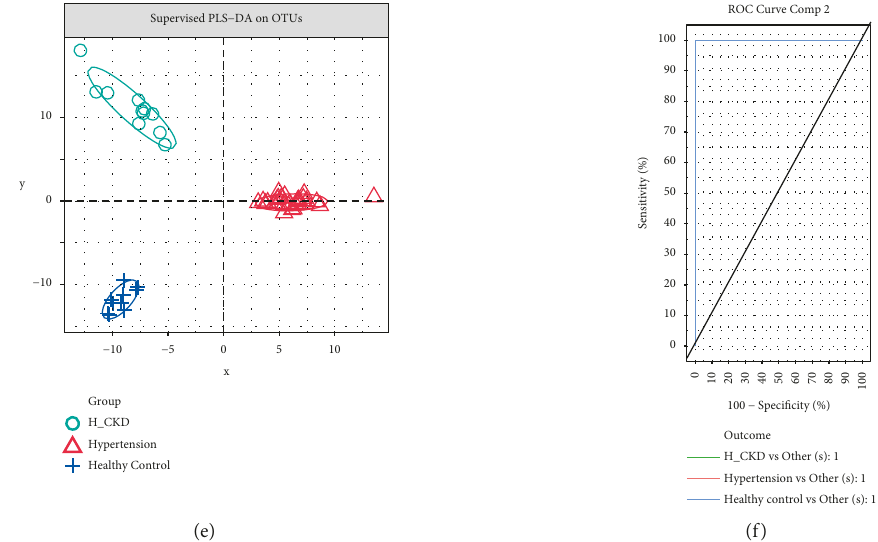
Figure 1: Comparisons of alpha-diversity and beta-diversity among the groups of H-CKD, hypertension, and healthy control. (a) Rarefaction curves for the mean of Shannon index in the three groups. The curve for each group is nearly smooth when the sequencing data are abundant enough with few new OTUs detected; (b) comparison of diversity in the three groups accessed by the Shannon index. Compared with the control group tested by the Kruskal–Wallis test, the α diversity of H-CKD group and hypertensive groups do not significantly decrease at the genus level; (c) PCoA analysis based on the weighted UniFrac matrix, the two components were 6.1% and 83.4%, respectively; (d) comparison of beta-diversity among the three groups. Overall, the fecal microbiota compositions do not significantly differ among the three groups, while the difference between Hypertension and healthy control is significant; (e) PLS-DA shows significant differences among the three groups; and (f) ROC analysis for the predictive value. The AUC of all the three groups are 1. OTU, operational taxonomic units; PCoA, principal coordinate analysis; PLS-DA, partial least squares discrimination